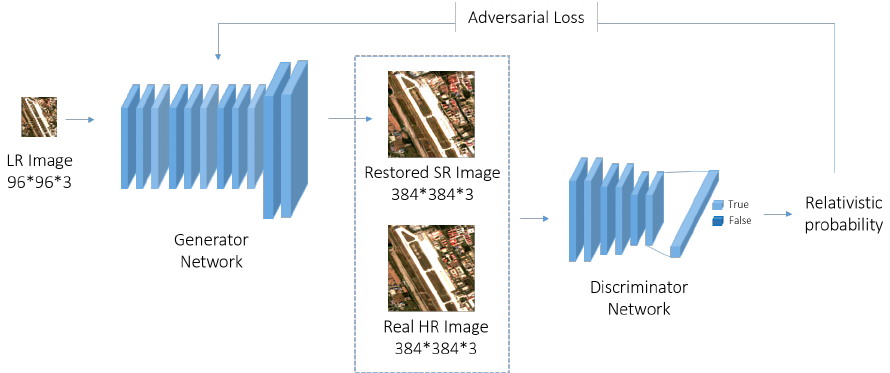
Figure 2. The demonstration of our GAN Structure. Given an LR image, we synthesis SR results from the G and compare it with the real HR one. The D is responsible for distinguishing the fake and real one, and thus provides adversarial loss for the training of the